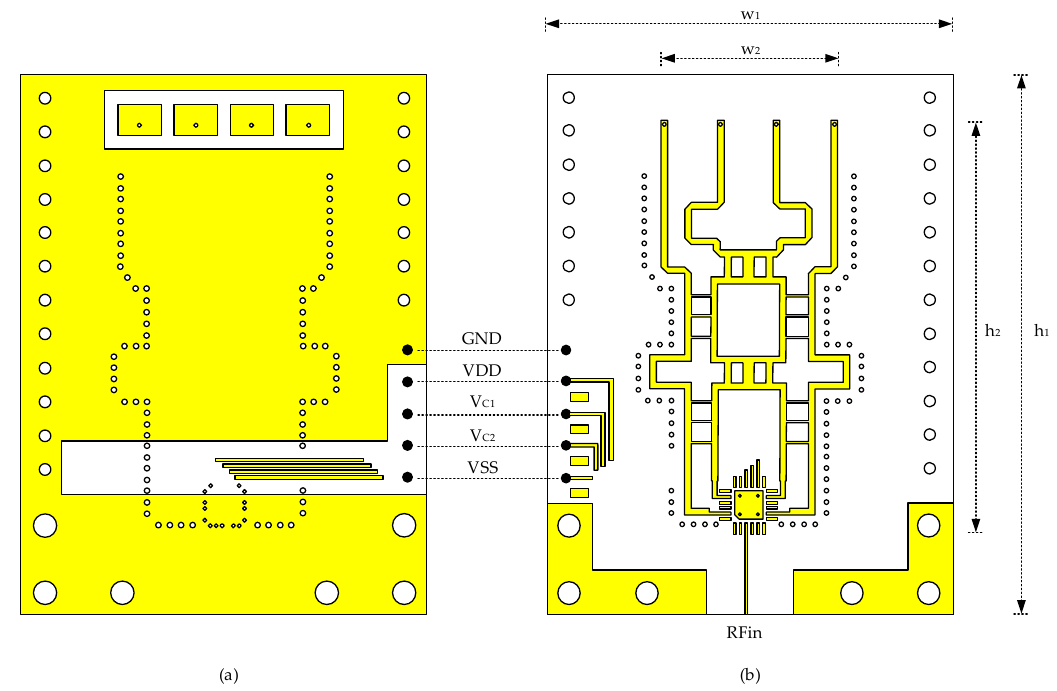
Figure 2. PCB layout. ( a ) antenna side (front), ( b ) beamforming circuit side (back).